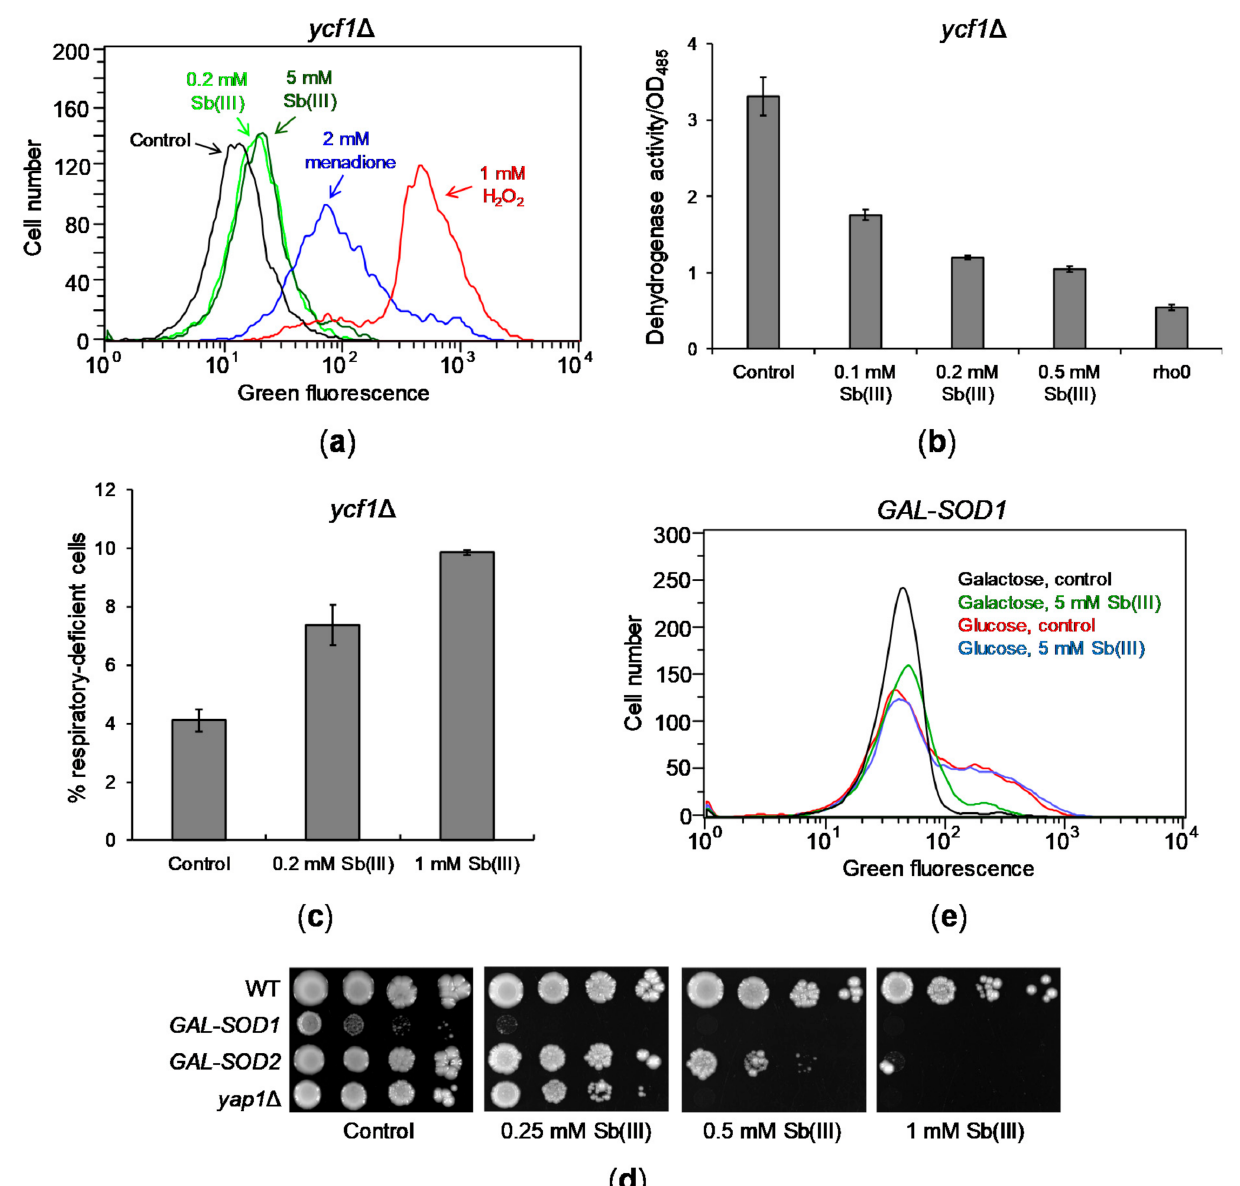
Figure 2. Sb(III) generates mild oxidative stress and mitochondrial dysfunction. ( a ) Sb(III) is a weak inducer of ROS production in yeast cells. The ycf1 ∆ mutant was exposed to indicated concentrations of Sb(III), menadione and H 2 O 2 in the presence of ROS probe DHR123 for 2 h and subjected to the flow cytometry analysis. Increased levels of green fluorescence reflects formation of R123 as a result of DHR123 oxidation by ROS. Black line, untreated culture; light green line, 0.2 mM Sb(III); dark green line, 5 mM Sb(III); blue line, 2 mM menadione; red line, 1 mM H 2 O 2 . ( b ) Sb(III) impairs mitochondrial functions as measured by downregulation of dehydrogenase activity. Reduction of colorless artificial substrate triphenyltetrazolium chloride (TTC) to a pink product was used to demonstrate the activity of dehydrogenase enzymes. The rho 0 mutant devoid of mitochondrial DNA was used as a positive control of respiratory defective cells. ( c ) Sb(III) elevates the rate of mitochondrial DNA loss. The ycf1 ∆ mutant was treated with indicated concentrations of